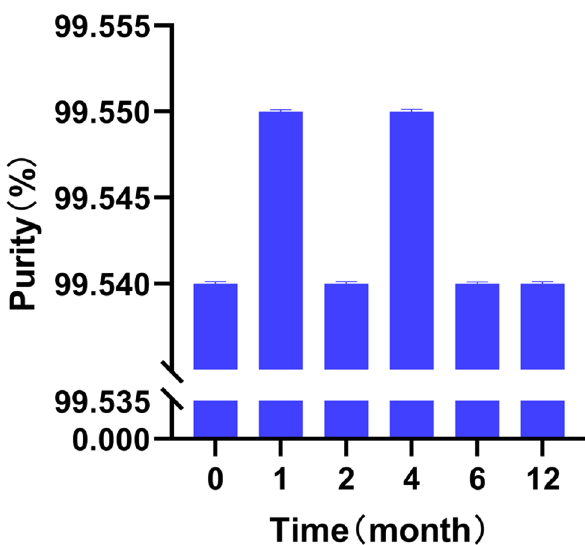
Table 4 Result of the minimum sampling amount